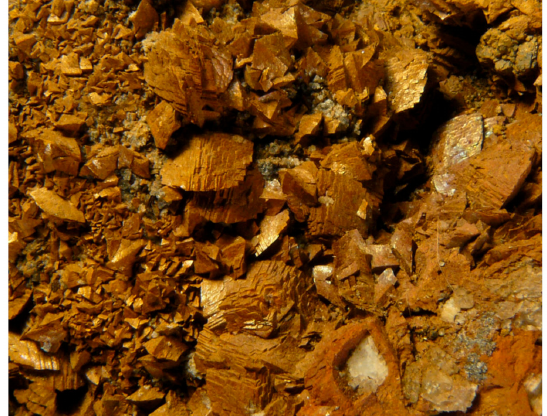
Figure 26. Goethite pseudomorphs after iron-rich dolomite, Whitton prospect. Field of view, 3 cm. Chamberlain Collection, NYSM 41317. SC.